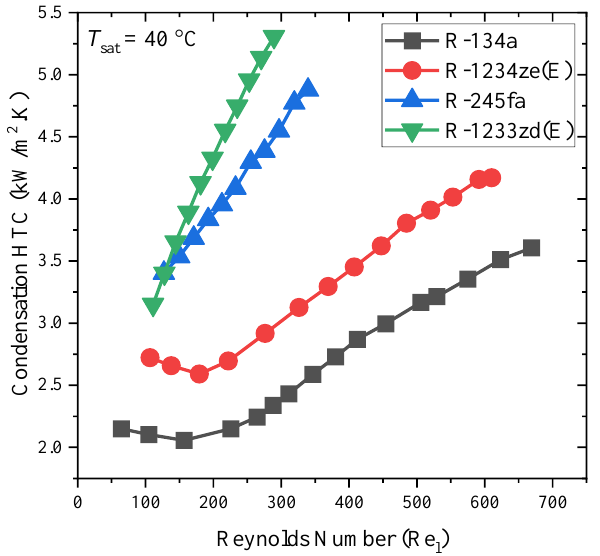
Figure 14. Comparative condensation heat transfer performance of R-134a, R-1234ze(E), R-1233zd(E), and R-245fa inside the plate heat exchanger (Zhang et al. [70]).